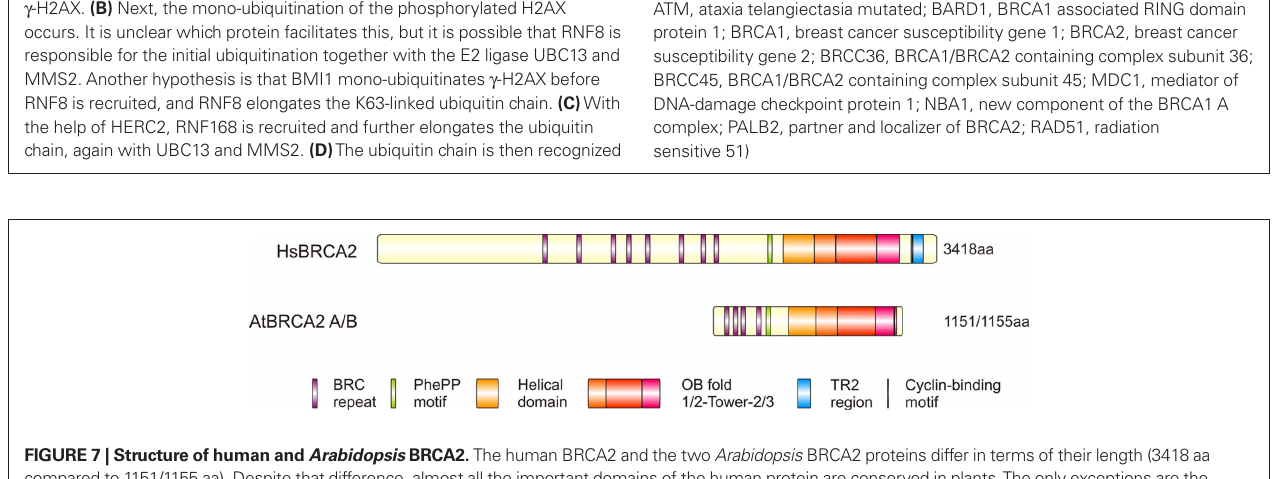
FiguRe 6 | Recruitment of the BRCA1 A complex to a DSB in mammals. (A) After a double strand break (DSB) is recognized, ATM phosphorylates the